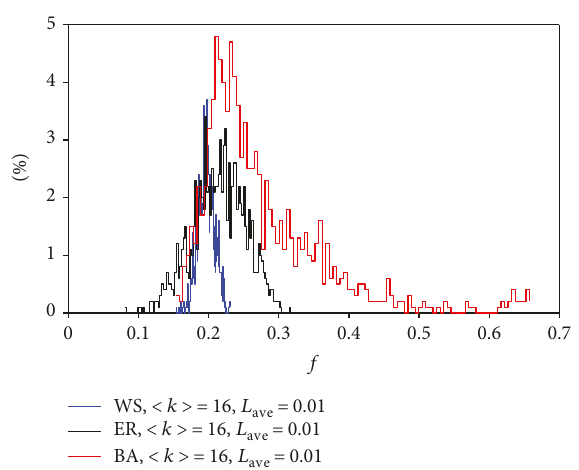
Figure 9: The evolution of risk contagion for three di ff erent networks with < k > = 16 and L ave = 0 01 .